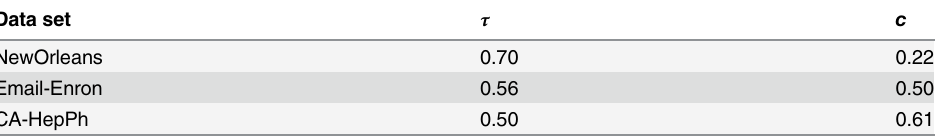
Table 2. τ of the real-world